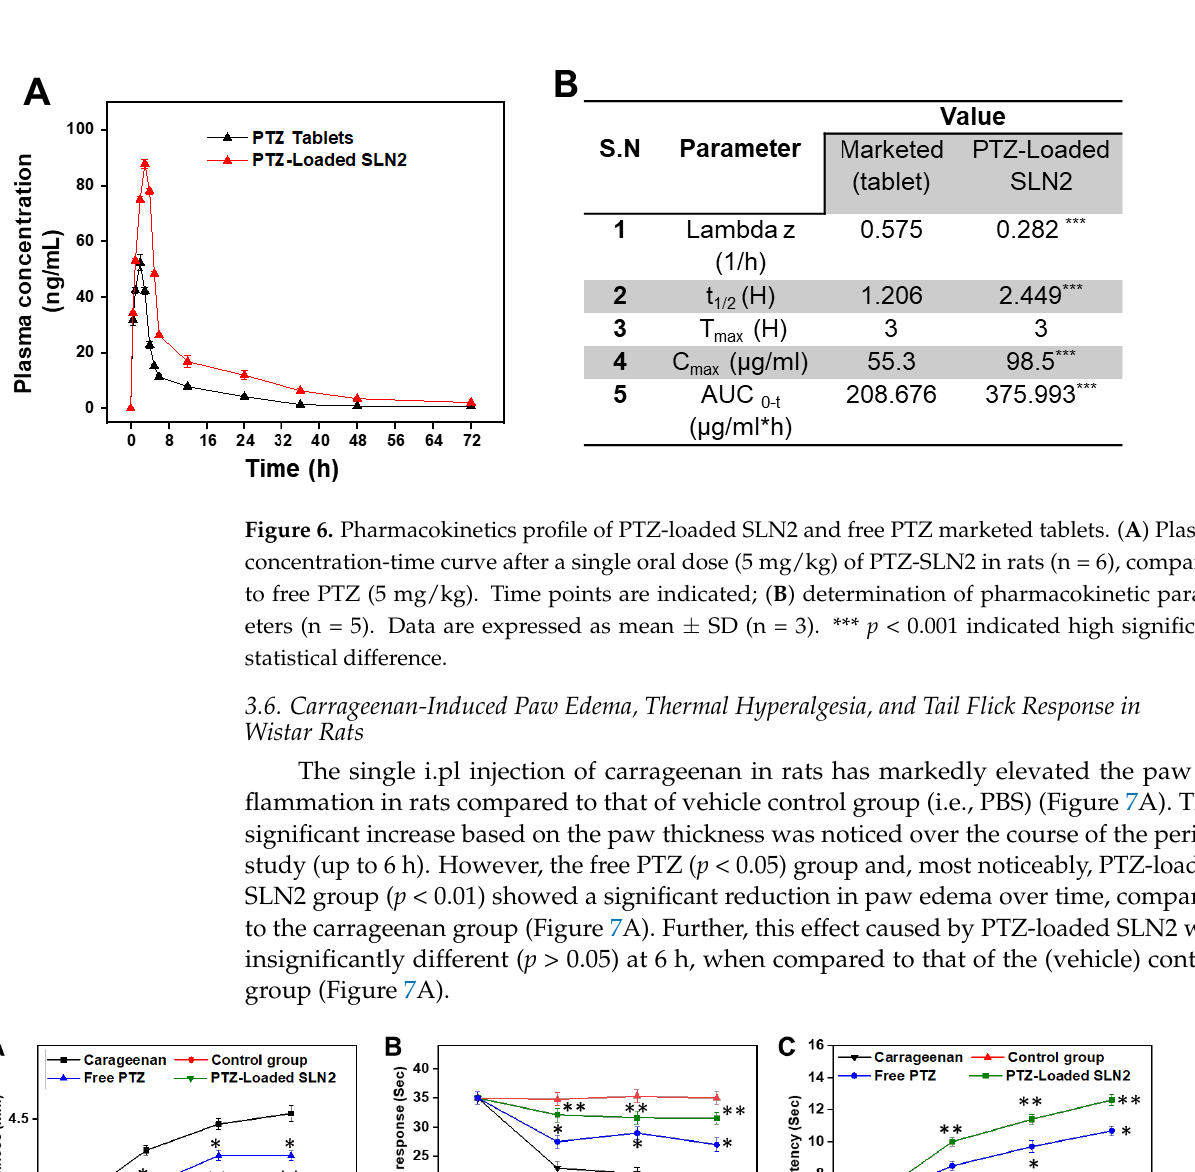
Figure 6. Pharmacokinetics profile of PTZ-loaded SLN2 and free PTZ marketed tablets. ( A ) Plasma concentration-time curve after a single oral dose (5 mg/kg) of PTZ-SLN2 in rats (n = 6), compared to free PTZ (5 mg/kg). Time points are indicated; ( B ) determination of pharmacokinetic parameters (n = 5). Data are expressed as mean ± SD (n = 3). *** p < 0.001 indicated high significant statistical dif- ference.